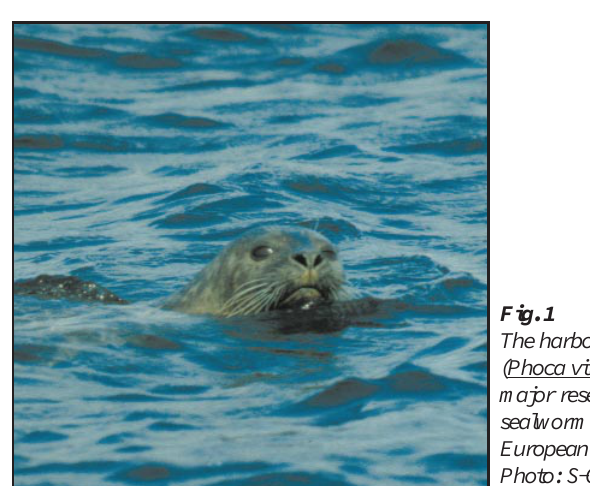
major reservoir for European